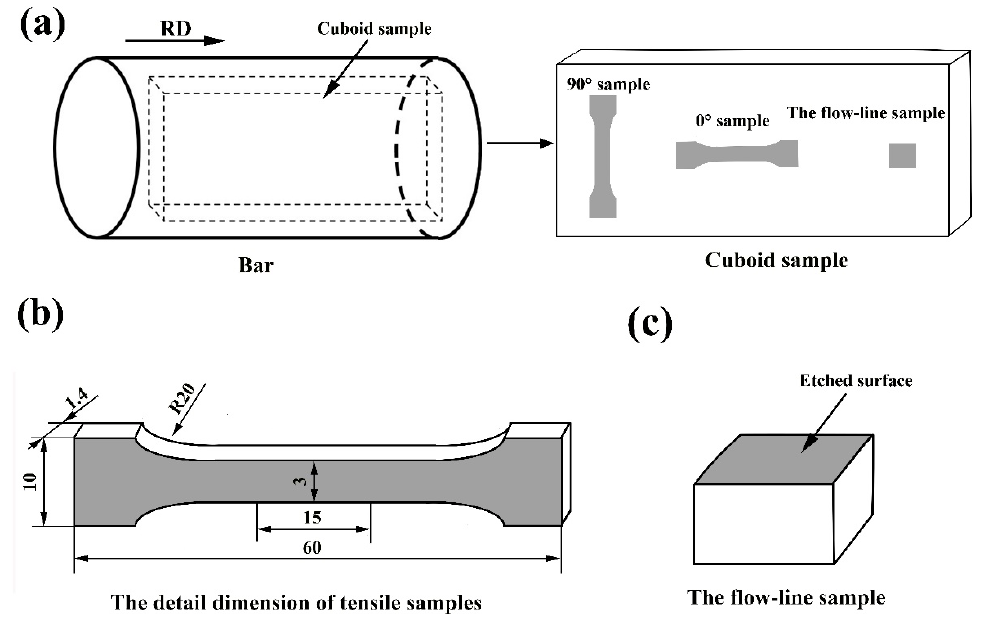
Figure 1. ( a ) Schematic diagram of the sampling process; ( b ) the details of the dimension of the samples used in tensile testing; ( c ) the diagram of the etched surface of the flow line sample.